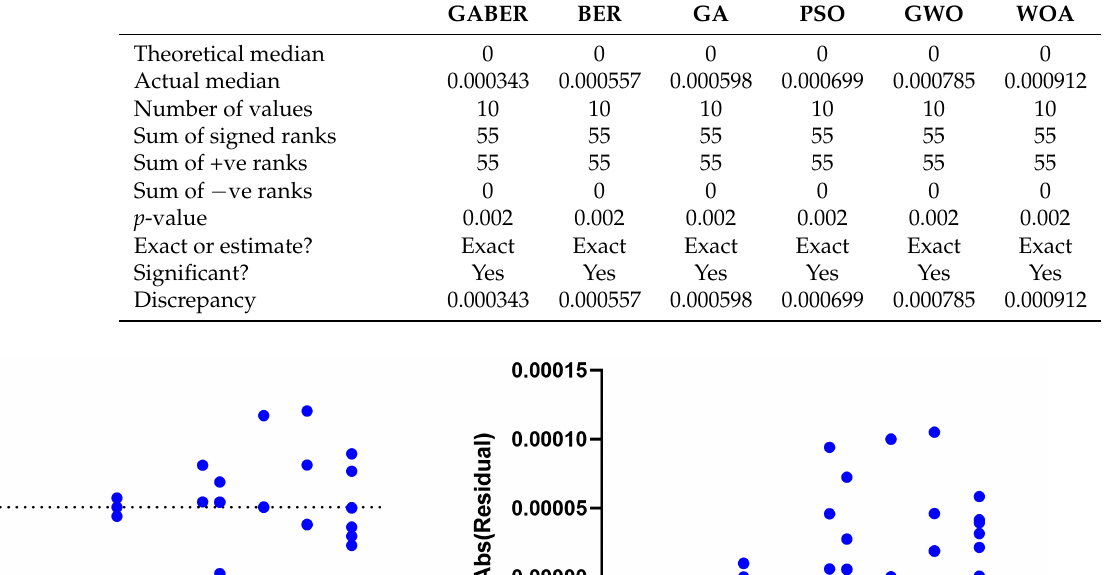
Table 11. Wilcoxon test applied the prediction results achieved by the proposed optimized ensemble model applied to the wind speed dataset.